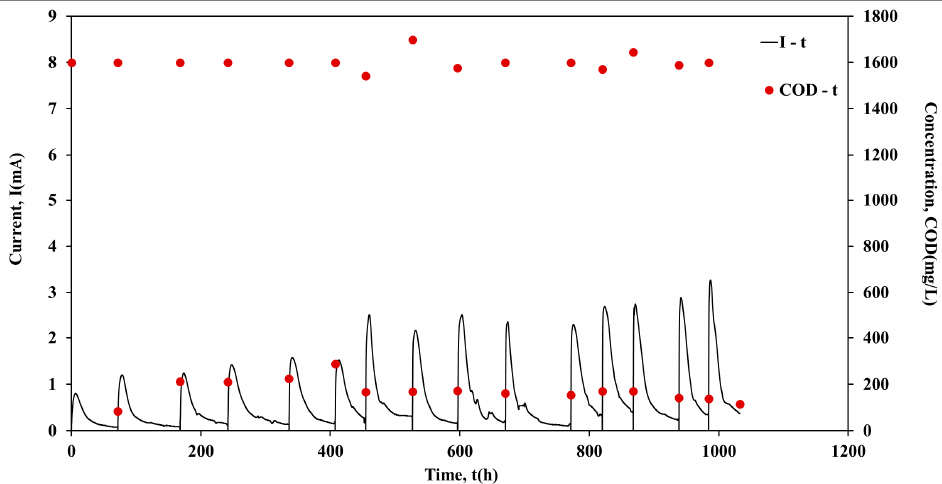
Figure 4. Current output (mA) and COD concentration (mg/L) versus time of Cell 4, during batch operation.